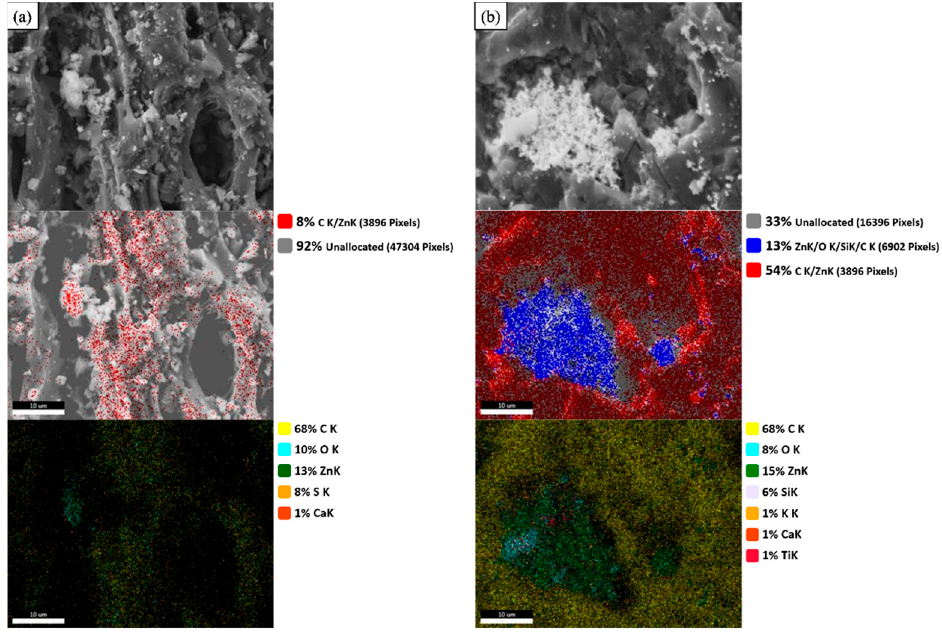
Figure 3. SEM mapping images of ( a ) ZnAc 2 /ZnO/CAC_DCM (F) and ( b ) ZnAc 2 /ZnO/CAC_OS (F) at 2.5K× magnification.